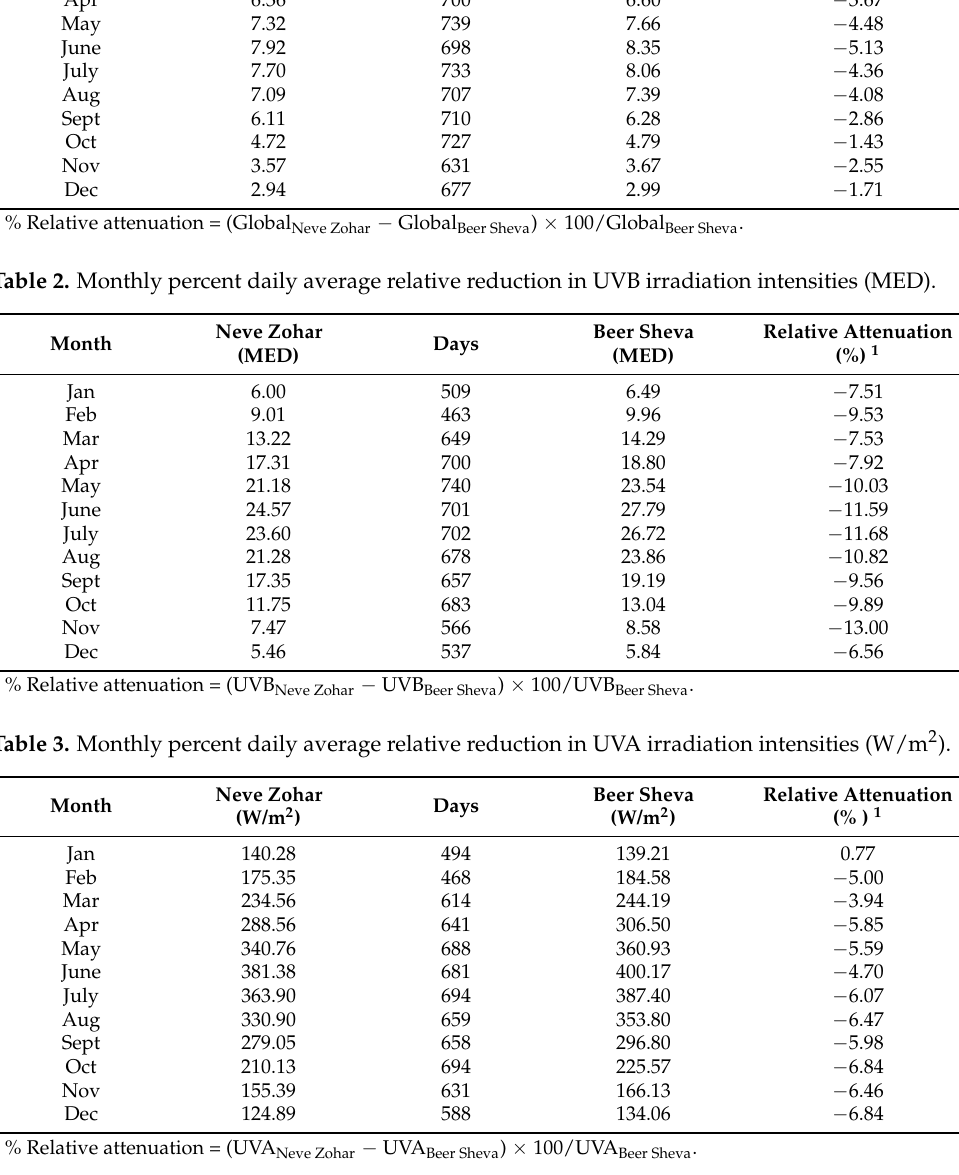
Beer Sheva Days (kW/m 2 )